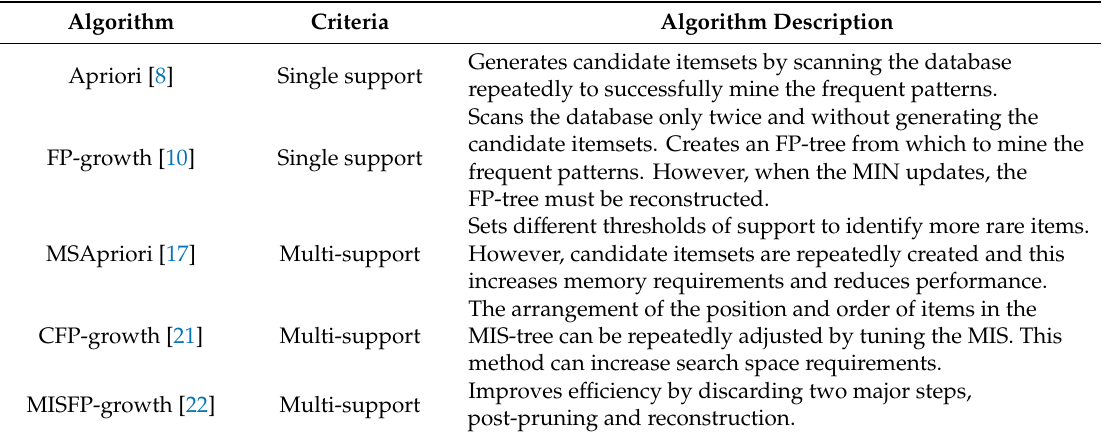
Table 1. Comparison of frequent patterns mining